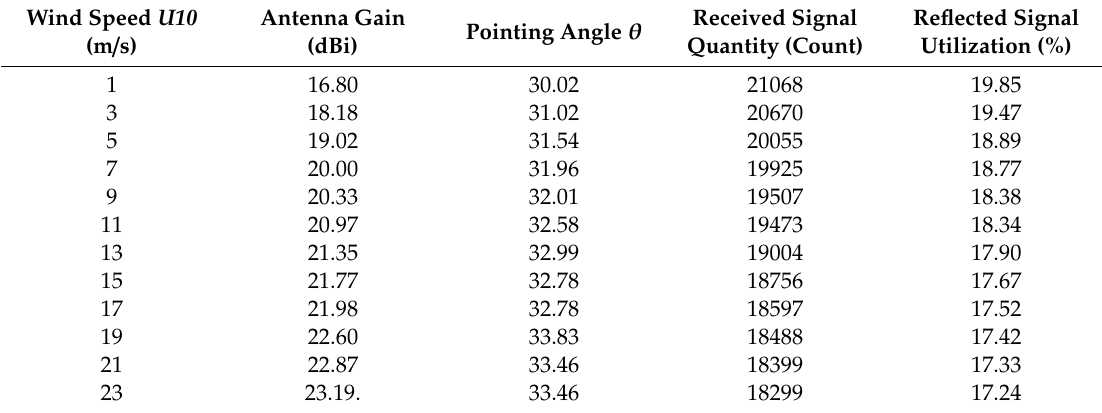
Table 3. Optimal parameters combination for nadir antenna observation capability with di ff erent sea surface wind